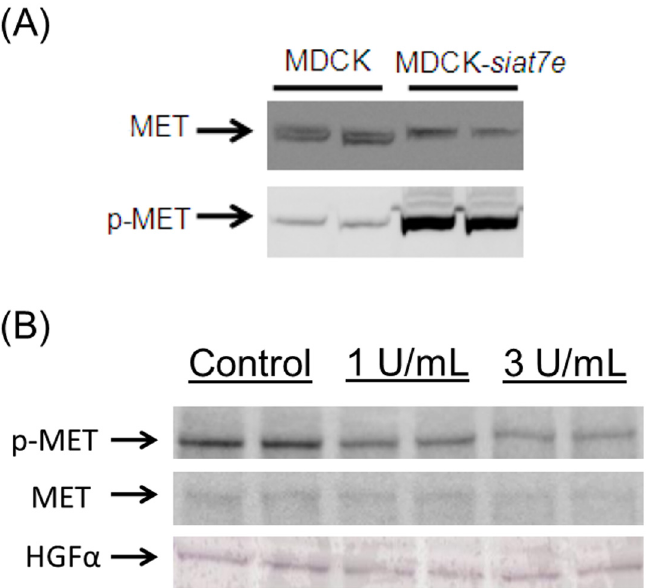
Fig 3. Activation of MET tyrosine kinase receptor in MDCK- siat7e cells. Duplicates are shown for each cell line/condition. (A) Cell line comparison of MET and p-MET at Tyr1234/1235. (B) Effect of sialidase treatment on MET phosphorylation in MDCK- siat7e